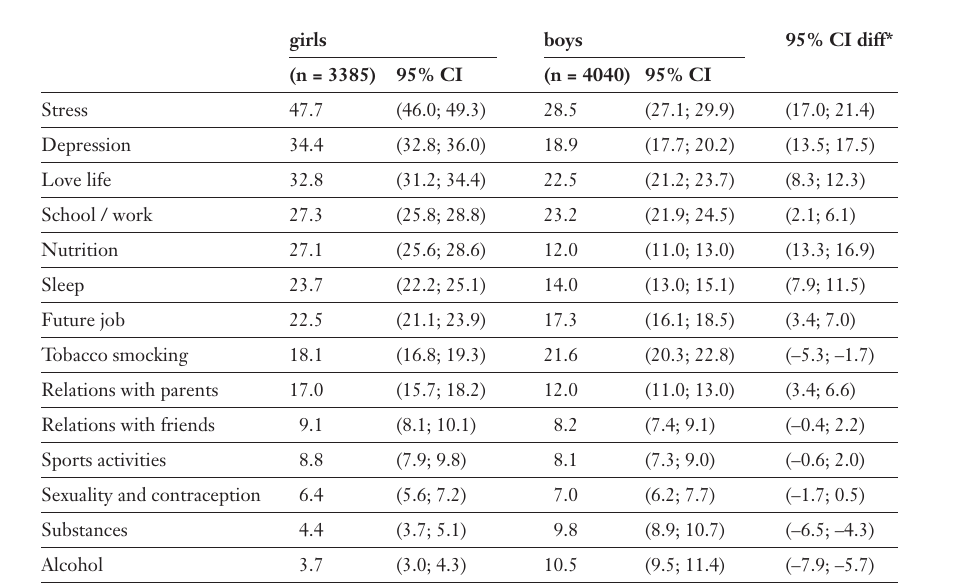
Table 2 Different areas of re- ported needs among